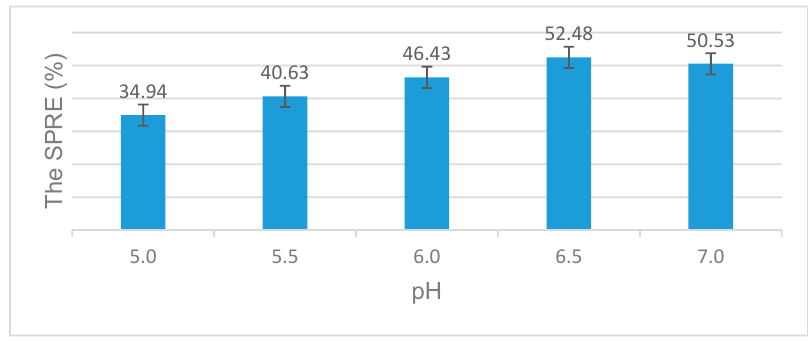
Figure 4. The effect of pH on the SPRE. Figure 4. The e ff ect of pH on the SPRE.